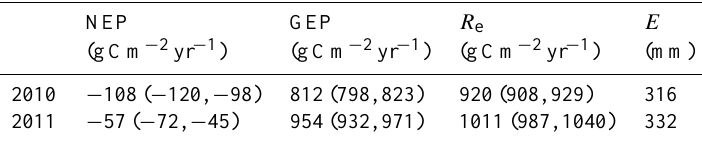
Table 3. Annual totals of net ecosystem production (NEP), gross ecosystem photosynthesis (GEP), ecosystem respiration ( R e ) in and evap- otranspiration ( E) at MPB-09 ∗ . Values in parentheses show the lower and upper 95% confidence intervals for the annual totals derived from the Monte Carlo simulation (see Sect. 2.3.2 for details).